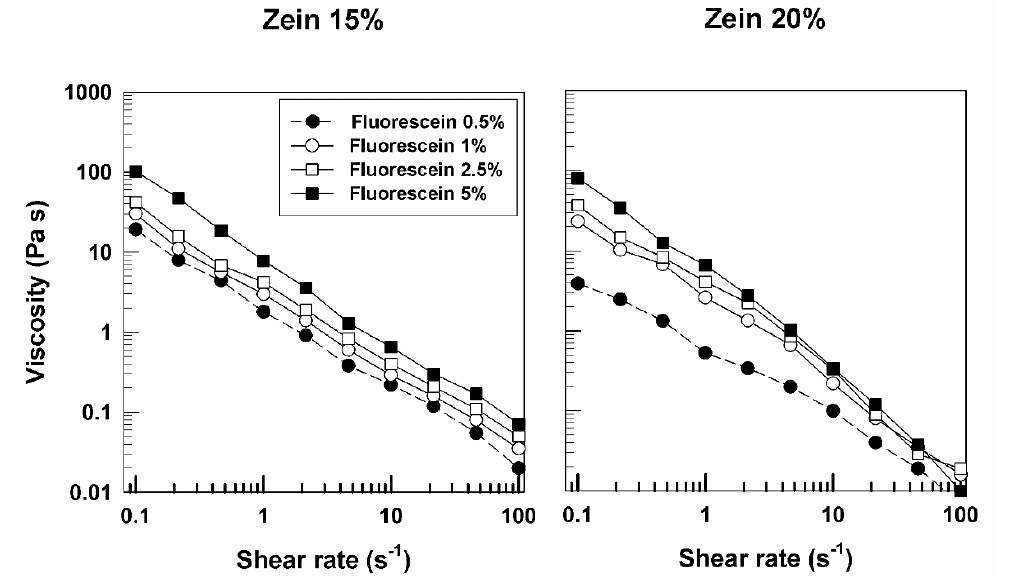
Figure 3. Evaluation of viscosity of zein samples containing disodium fluorescein as a function of the shear rate.